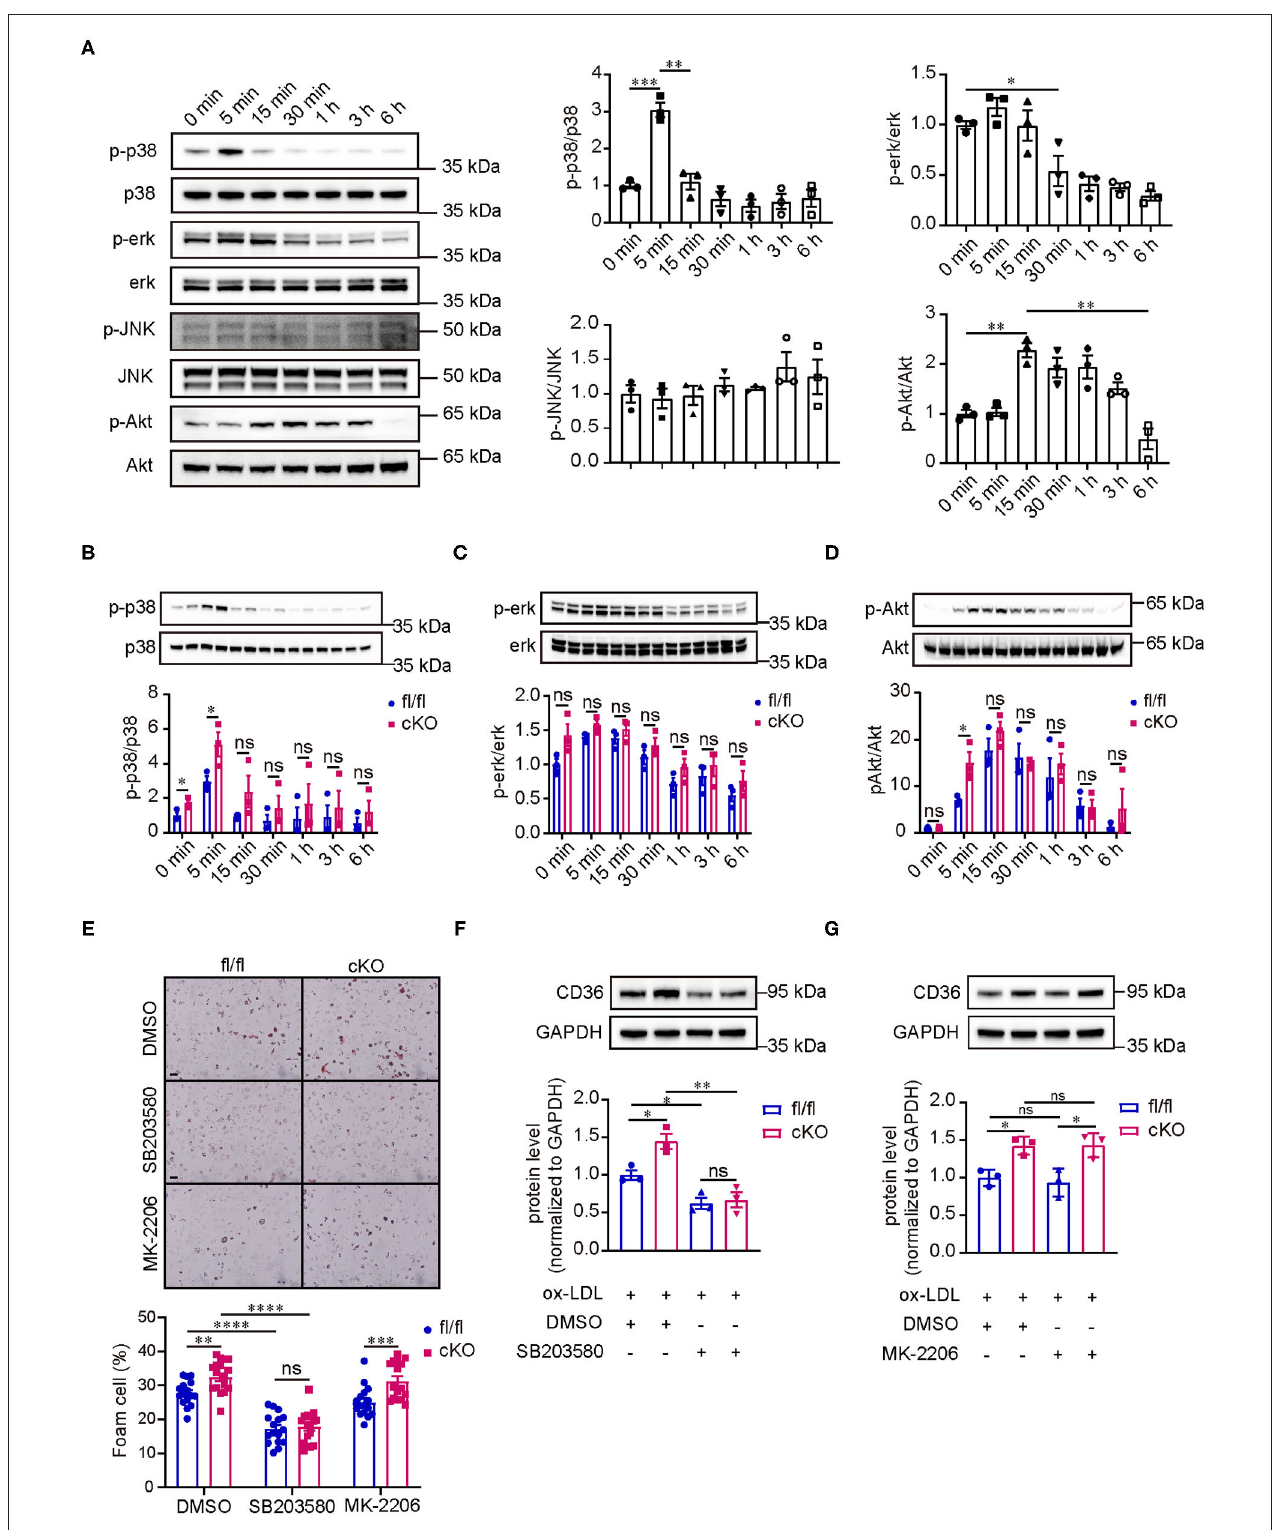
FIGURE 5 | PP2A regulates the expression of CD36 and foam cell formation via p38 MAPK signaling pathway. (A) Western blot analysis revealed the phosphorylation level of p38/ERK/JNK MAPKs and AKT signaling pathways in peritoneal macrophages isolated from C57BL6 mice treated with oxLDL at 0, 5min, 15min, 30min, 1h, 3h, and 6h ( n = 3). (B–D) Images of western blot detecting the phosphorylation level of relevant signaling pathways at indicated times for cKO and fl/fl peritoneal